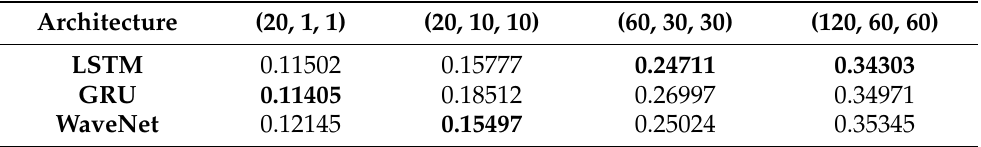
Table 2. Best Mean Absolute Error (MAE) reached in different grid searches. Architecture